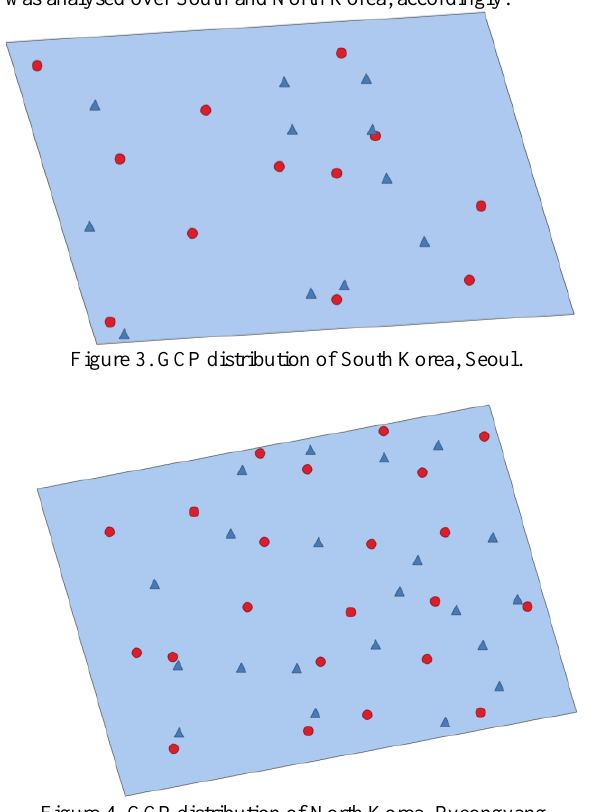
Figure 4. GCP distribution of North Korea, Pyeongyang.